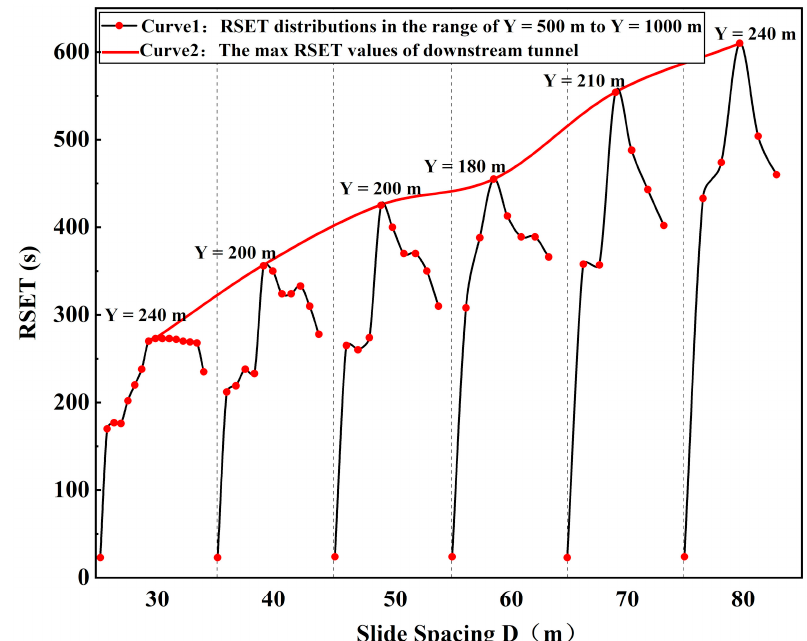
Figure 9. RSET distributions in conditions of different slide spacing (D).